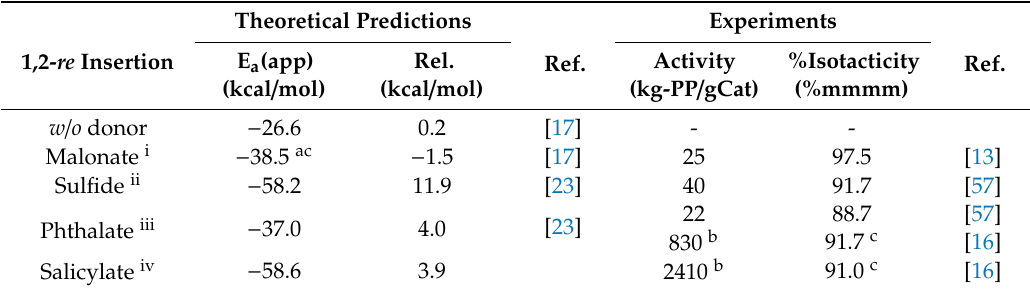
Table 5. Apparent activation energy (E a (app)) of primary (1,2) -re insertion, relative barrier (Rel.), experimental activity, and %isotacticity of ZN-catalyzed PP polymerization in absence of donor ( w / o donor) and with malonate, sulfide, phthalate, and salicylate donors.